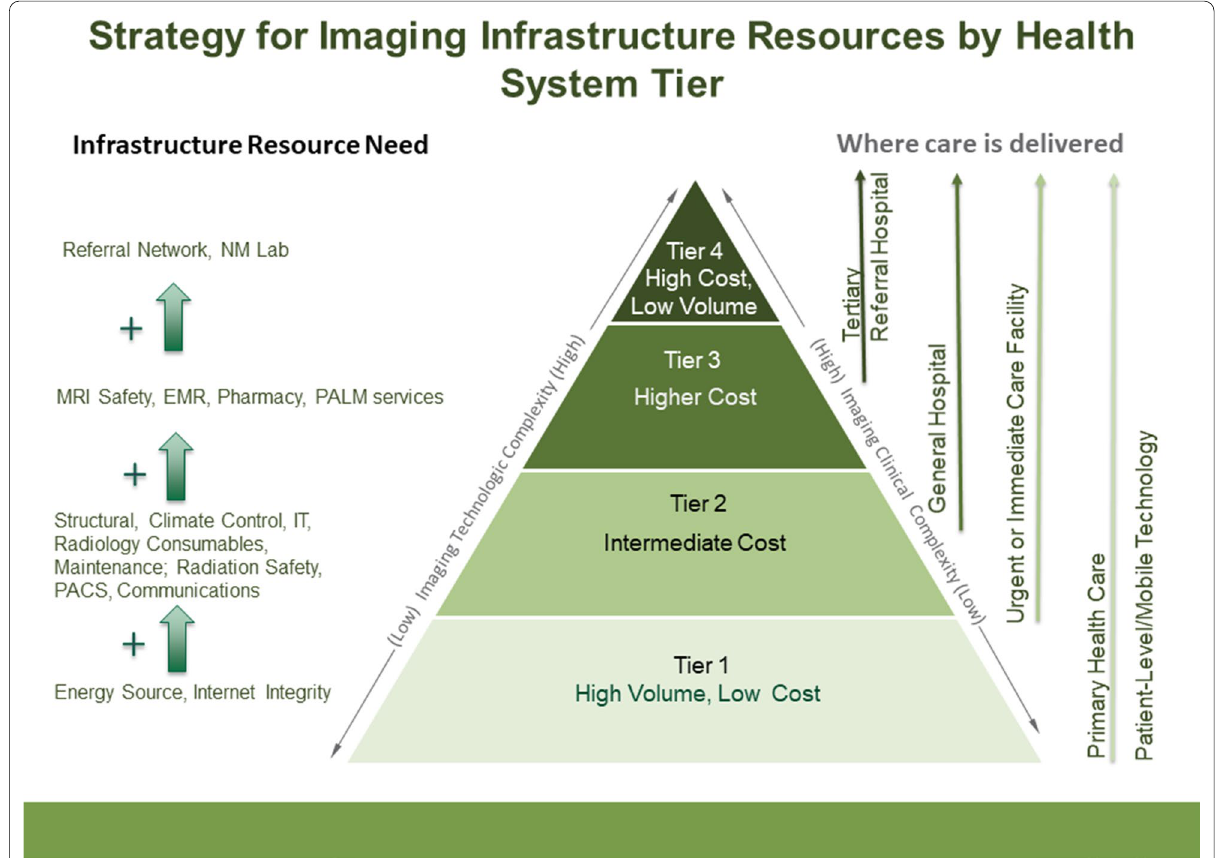
Fig. 5 Recommended imaging infrastructure resource strategy by health system tier. Higher levels on the pyramid denote increasing complexity and requirement for more sophisticated and specialized infrastructure. Green arrows indicate added infrastructure required at the next highest tier (POCT Point‑of‑care testing; IT Information Technology; PACS Picture Archiving and Communication system; MRI = = = imaging; EMR electronic medical record; NM nuclear medicine; PALM pathology and laboratory = = =